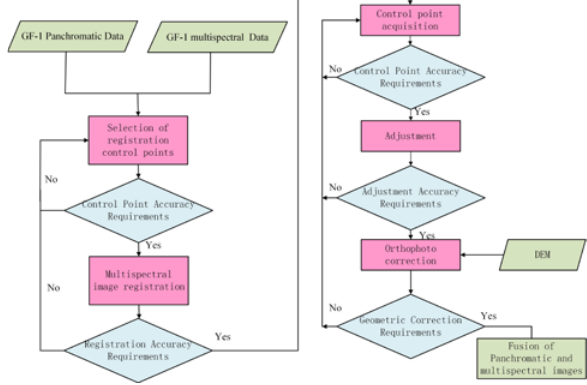
Figure 5. GF-1 image preprocessing